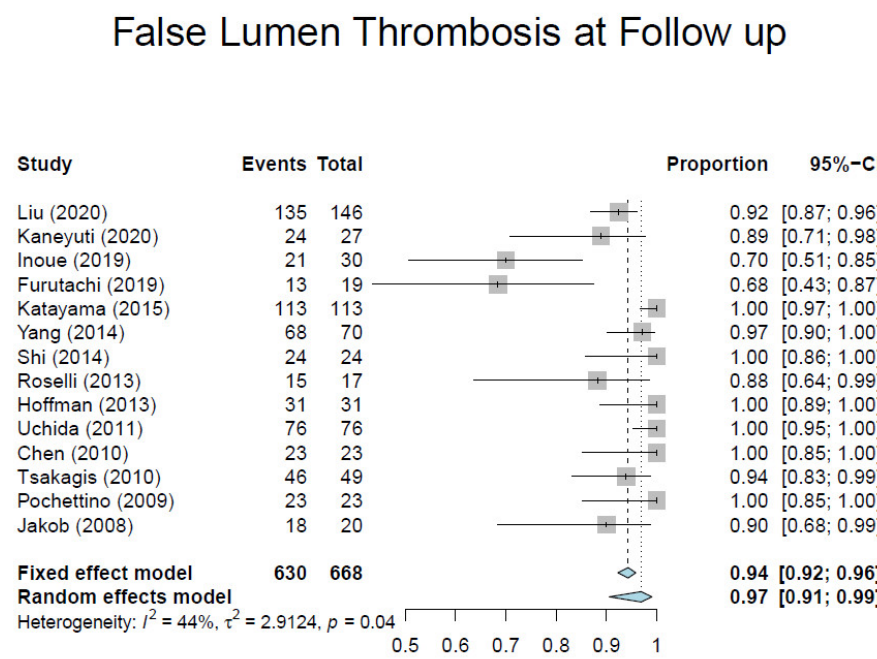
Figure 6. Forest plot depicting pooled estimates of distal aortic re-operation at follow-up.